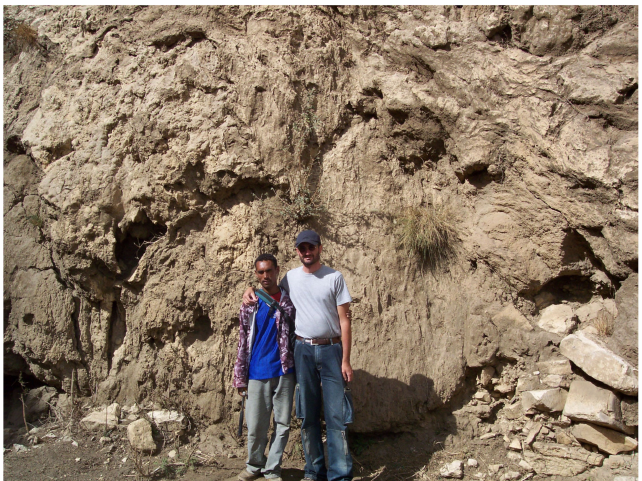
Figure 3. Phytohermal tufa at Romanatt Dam (Tigray,